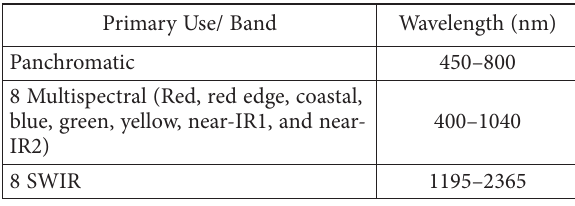
Table 1. Worldview-3 imagery specifications